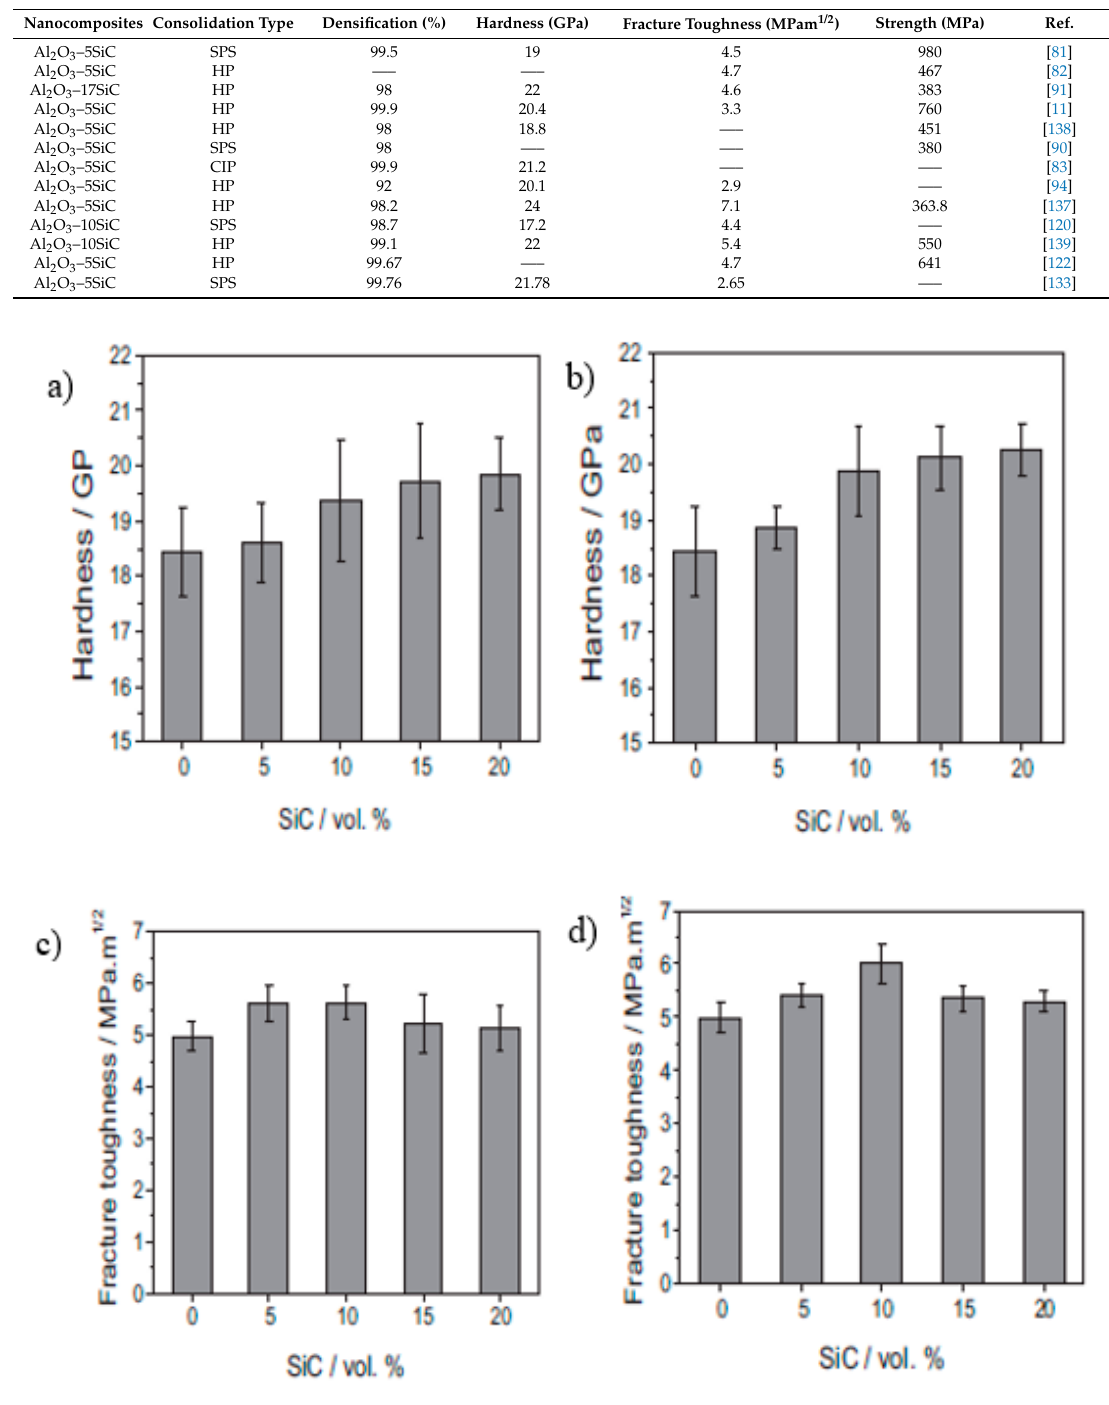
Table 1. Mechanical properties of Al 2 O 3 –SiC nanocomposites.